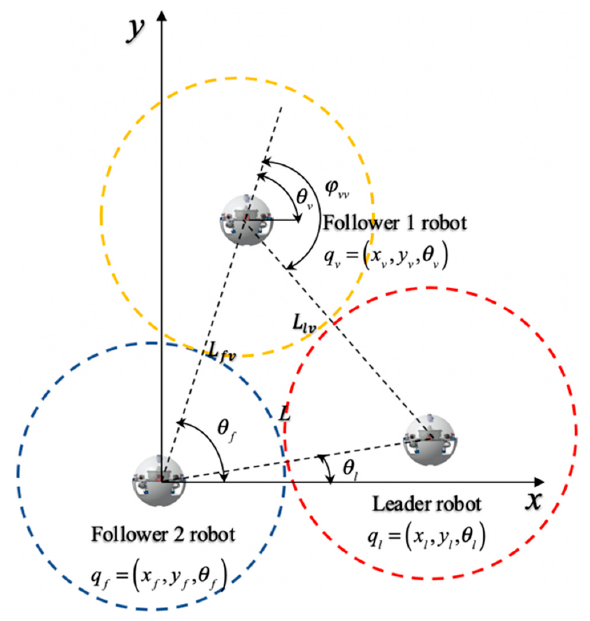
Figure 9. Multi - robot representation in the Cartesian coordinates. Figure 9. Multi-robot representation in the Cartesian